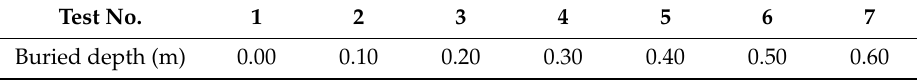
Table 2. Buried-depth status of the buried metal pile (full length 1.00 m).